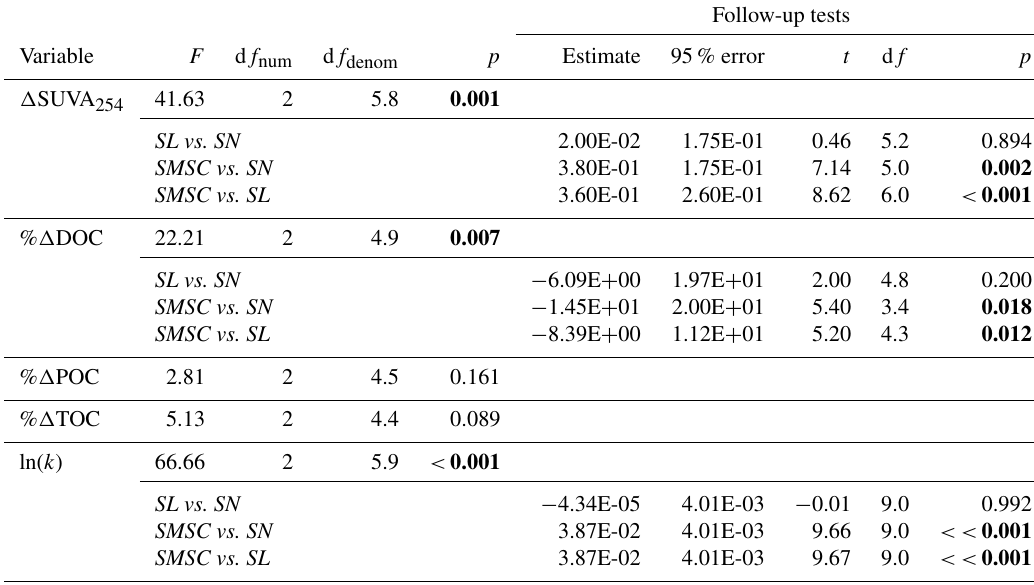
Table A2. Welch’s ANOVA and follow-up Games–Howell pairwise t tests of differences between size fractions (2016 experiment). P values for main ANOVAs are adjusted for false discovery rate to account for multiple outcomes tested (five tests). Follow-up tests were only conducted when main ANOVA tests showed a significant difference. Size fractions: SN = 63–2000µm, SL = 20–63µm, SMSC = < 20µm. P values below 0.05 are in bold font.